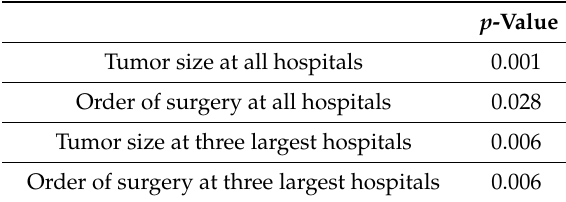
Table A1. Connection between the probability of recurrence within 24 months and the variables tumor size and surgical order.